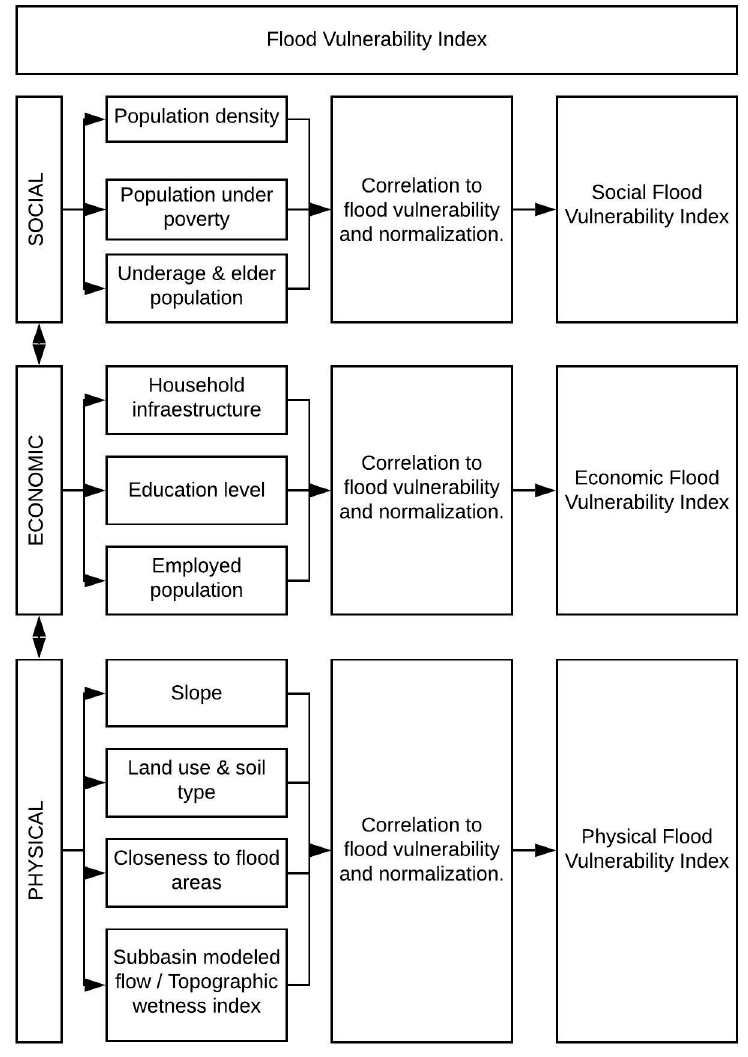
Figure 1. Flood vulnerability components and indicators processing methods.